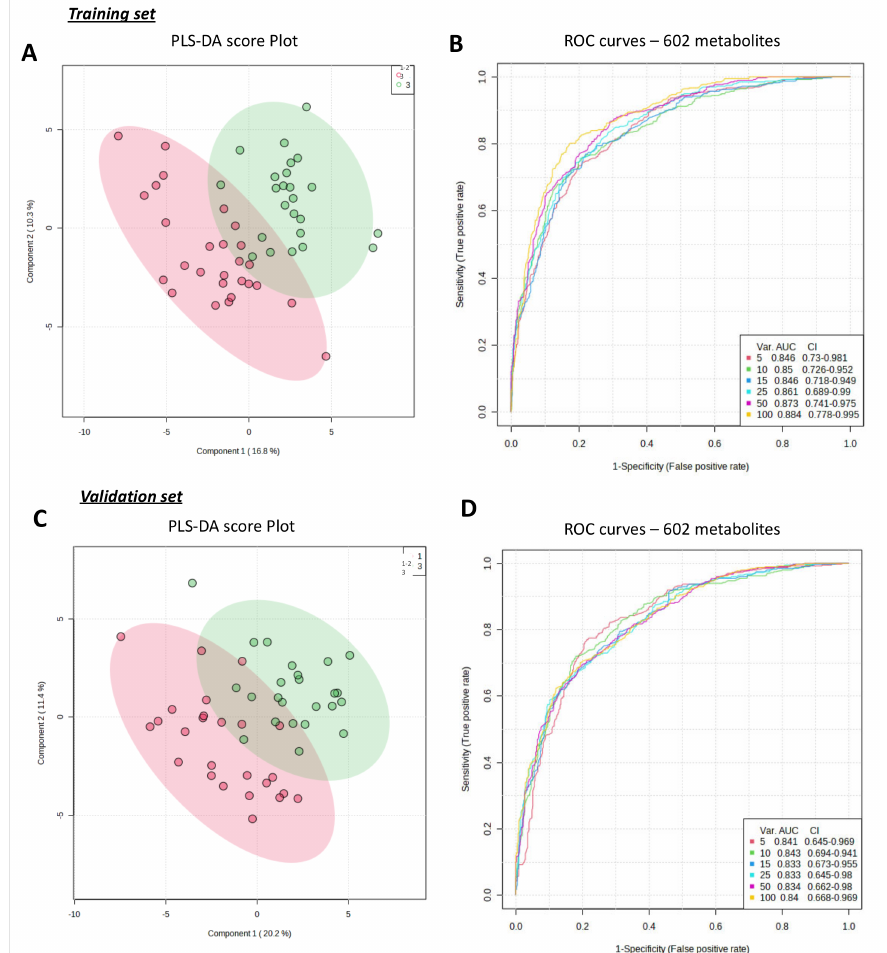
Figure 1. Metabolomic fingerprinting allowed accurate discrimination of SBR grades using 602 pre- dicted metabolites found in both the training set and the validation set. ( A ) shows the score plot of the PLS-DA on the training set, which can accurately discriminate between high-grade (grade III—green dots) and low-grade (grade I–II—red dots) groups. ( B ) shows the AUCs of the ROC of different metabolomic signatures for the training set, which included an increasing number of metabolites (var.), with their respective 95% confidence interval values (95%CI). The score plot of the PLS-DA and ROC curves for the validation set are shown in ( C , D ),